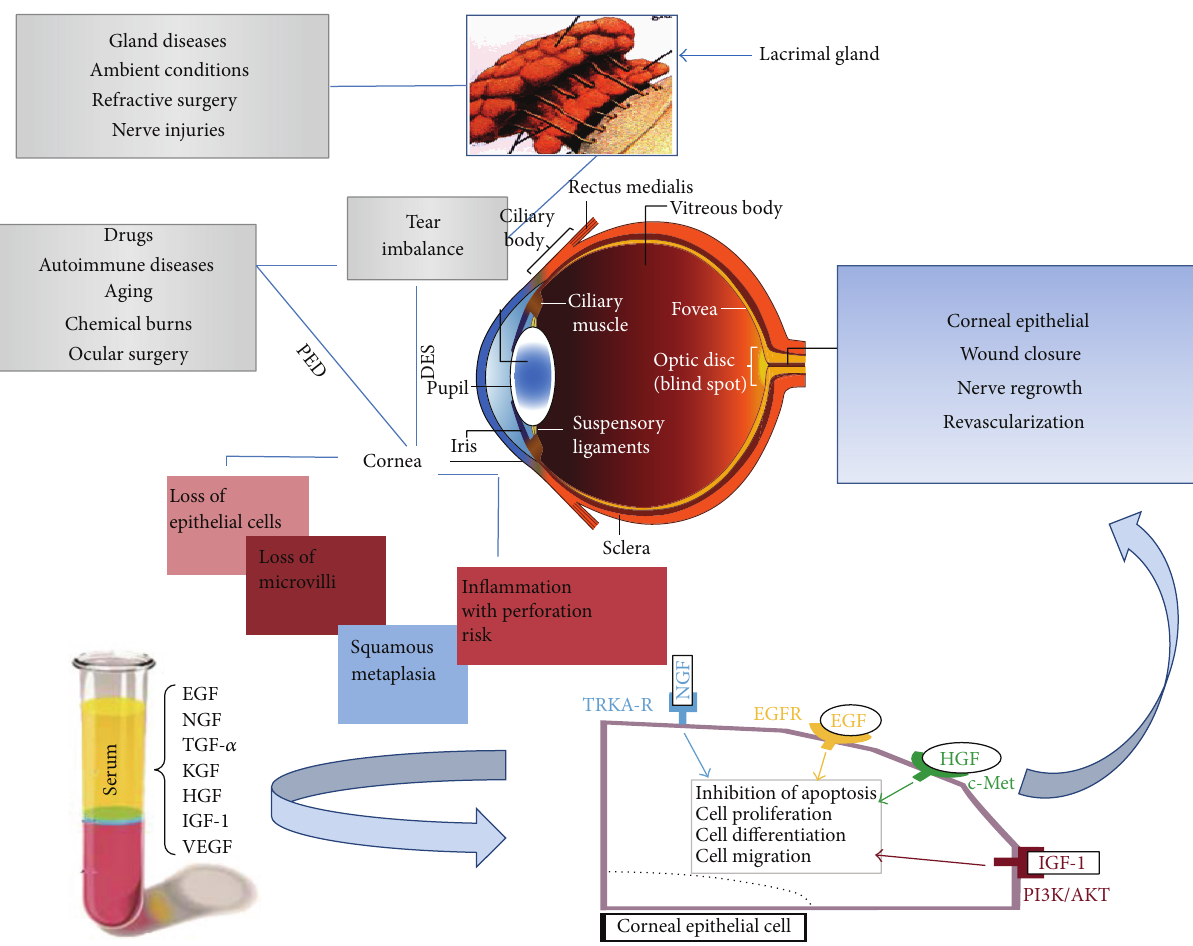
Figure 1: Mechanisms involved in damaged cornea and serum growth factor regeneration pathways. Several corneal injures can promote pathological conditions such as PED or DES. Action of drugs, autoimmune diseases, aging, chemical insults, and postsurgical lesions can wound the cornea directly or indirectly through the imbalance of the lachrymal gland. Microscopically, these pathogenic conditions result in a loss of epithelial cells and microvilli, epithelial squamous metaplasia, and inflammation of the corneal surface. The corneal healing process can benefit from the promoting action of serum GFs. Once they are released, through tyrosine kinase receptors, they propagate their signal from the plasma membrane to the nucleus. Through explicit pathways and signaling cascades, GFs activate the expression of target genes involved in apoptosis, proliferation, cell differentiation, and migration. This synergistic action establishes regenerative effects with closure of epithelial lesions, revascularization, and